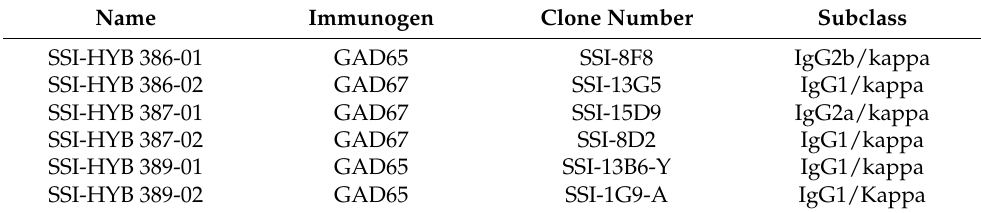
Table 1. Antibody clones selected for final characterization.